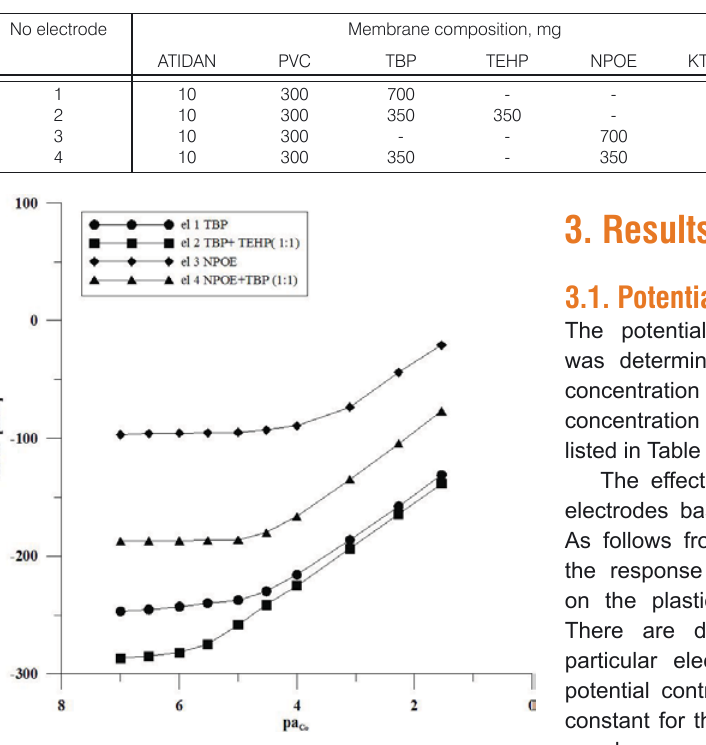
Table 1. Optimisation of membrane ingredients and membrane